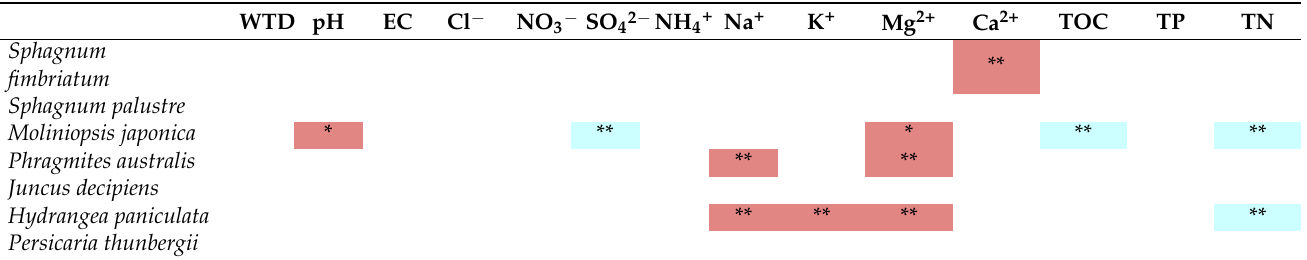
Table 7. Significance levels of correlation between coverage of each abundant species and water envi- ronmental variables in transects of the TDW transect, BGT transect 1, and BGT transect 2. Significance levels of Spearman’s’ correlation coefficient were shown. Red-colored cells mean significant positive correlations and blue-colored cells mean significant negative